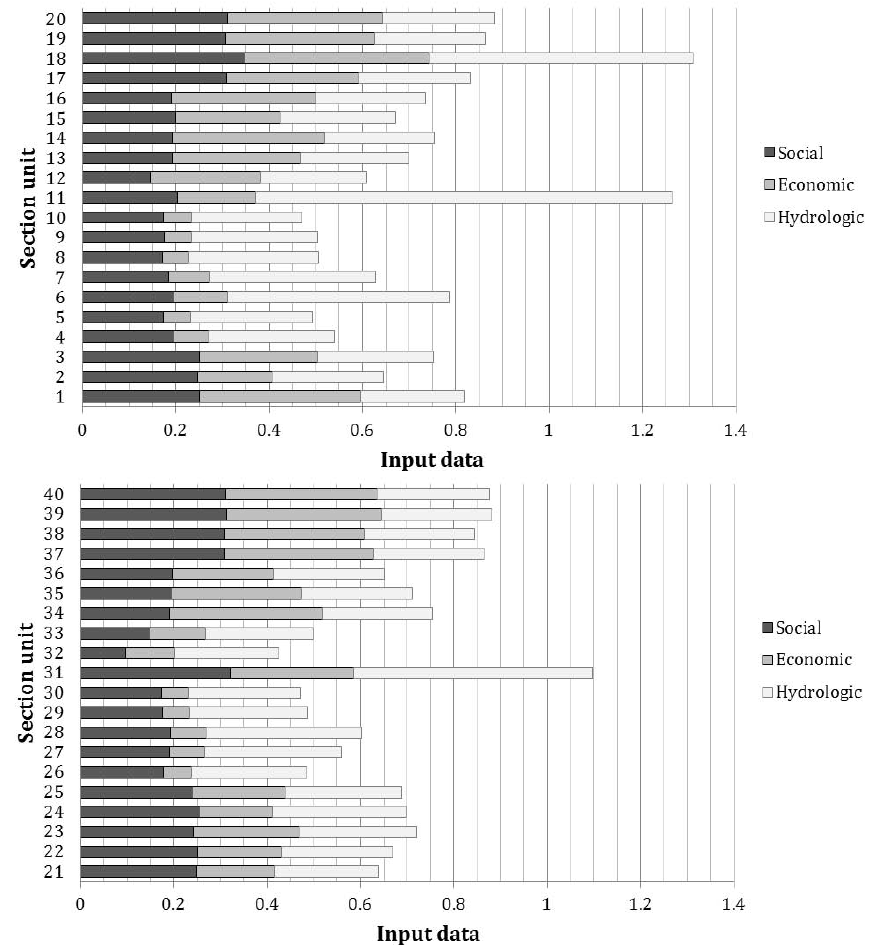
Fig. 10. Normalised input data of the characterised